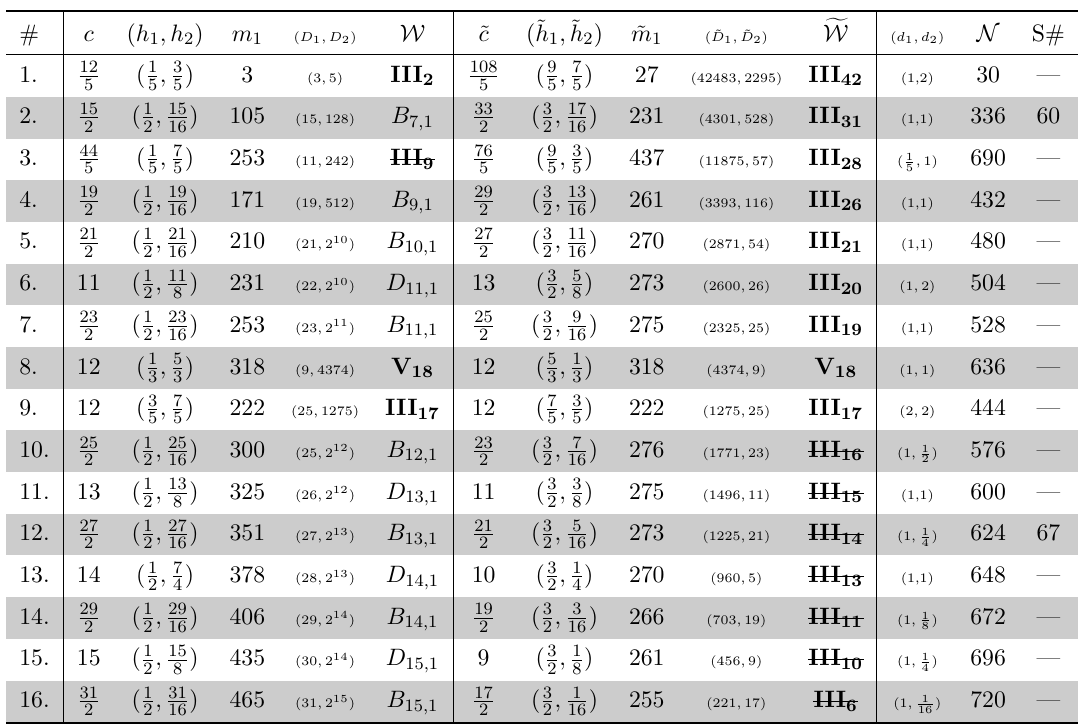
Table 10. Inconsistent pairings, c H = 24 with ( n 1 , n 2 ) = (2 , 2) . Wherever present, the entry in the last column identifies a candidate meromorphic theory by its row number in the table of